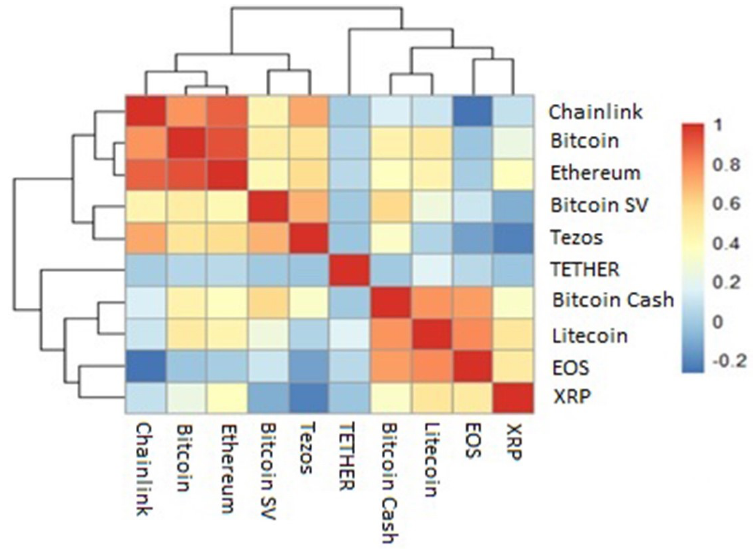
Figure 2. This figure shows the correlation among ten cryptocurrencies. Log prices of all cryptocur- rencies have been used to calculate the correlation. Data are daily prices from coingeco.com. The sample period covers 11 November 2018 to 31 December